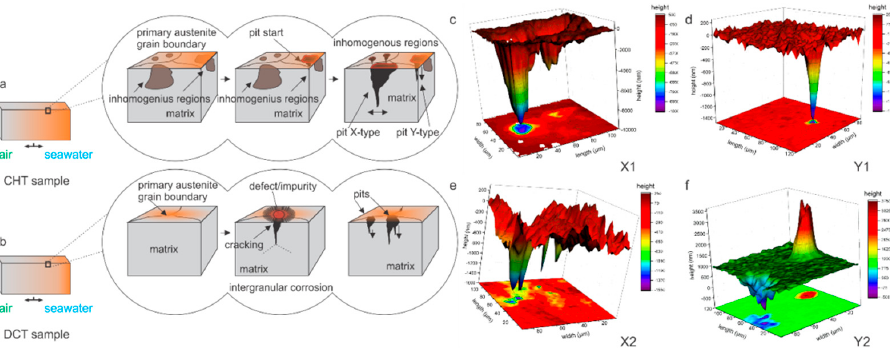
Figure 5. ( a , b ) Graphical representation of pit growth regarding heat-treated state of investigated steels conventional (CHT) and deep cryogenic (DCT) heat treatment. CHT sample pit growth resulting from direct vertical grain attack within inhomogeneous regions ( a ). DCT sample pit growth resulting from intergranular corrosion on defect/impurity portions of the primary austenite grain boundaries ( b ). ( c , d ) Three-dimensional measurements of pits in CHT X1 and Y1 samples. ( e , f ) Three-dimensional measurements of pits in DCT X2 and Y2